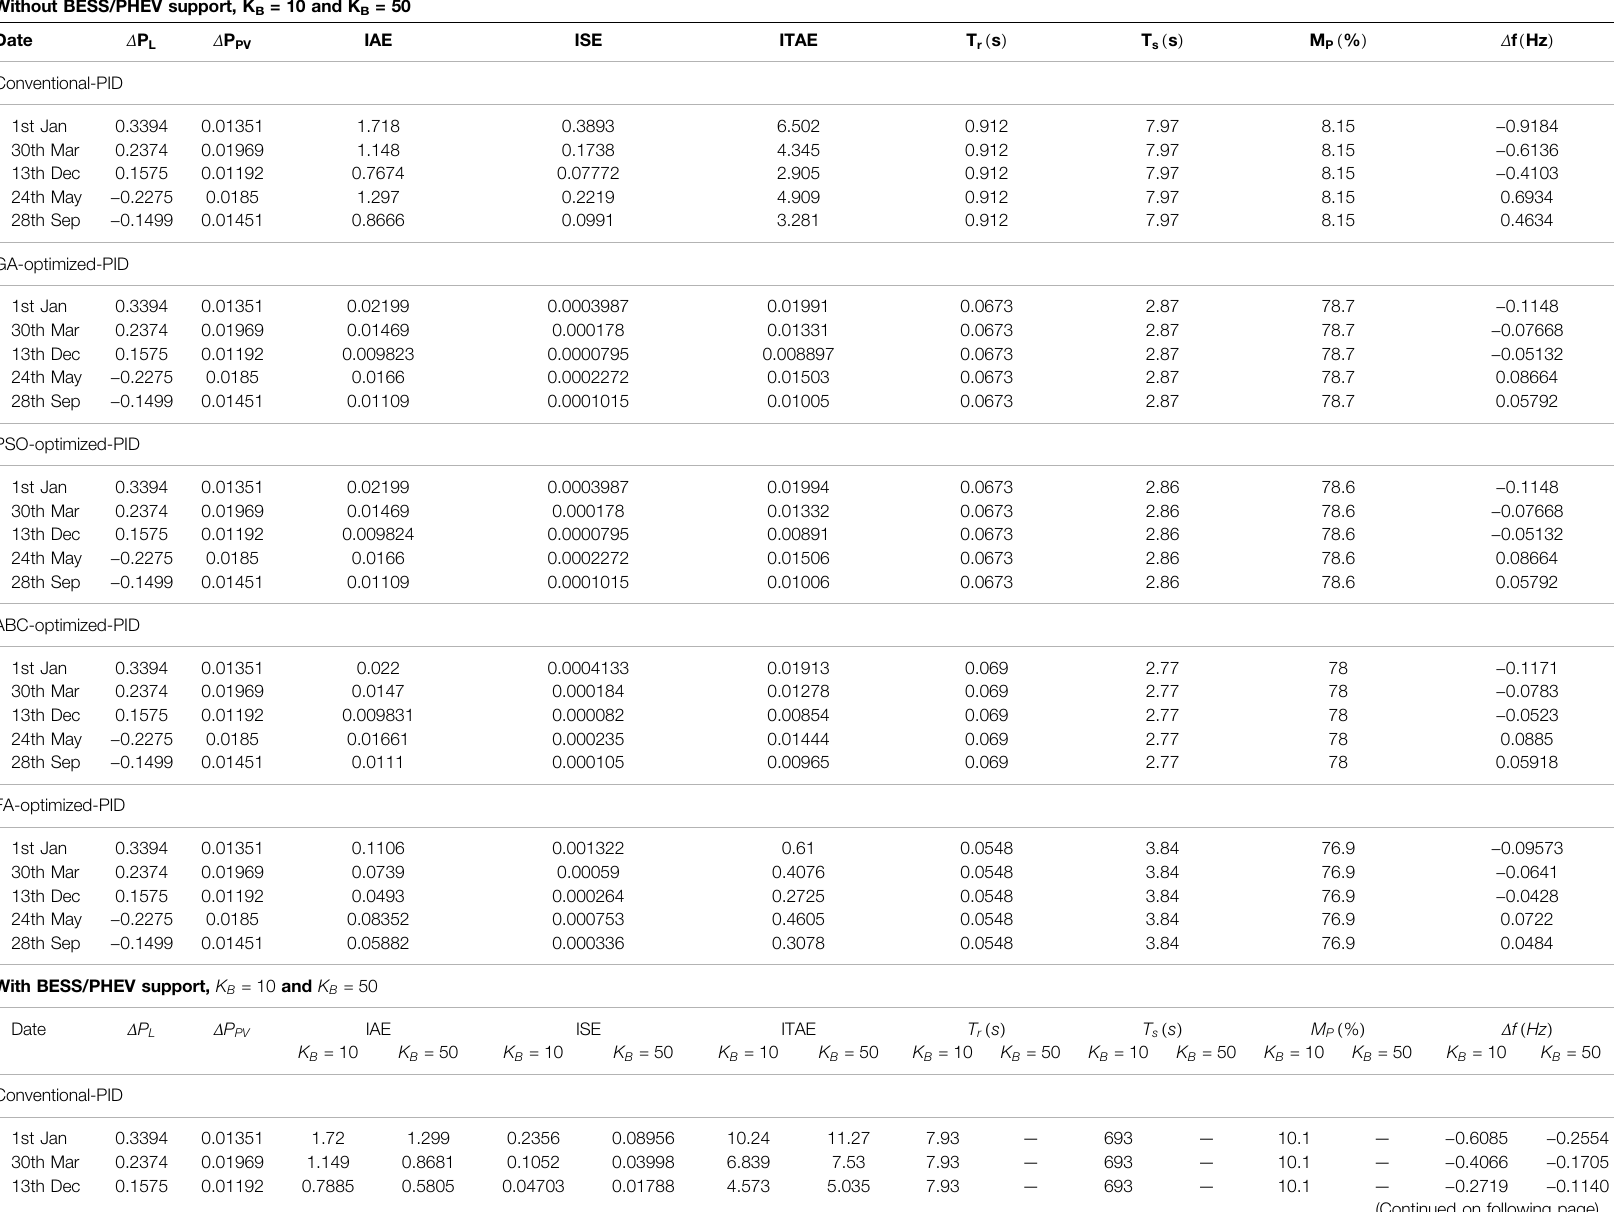
TABLE 6 | Frequency deviation parameter indices using integral absolute error objective function. Without BESS/PHEV support, K B = 10 and K B =